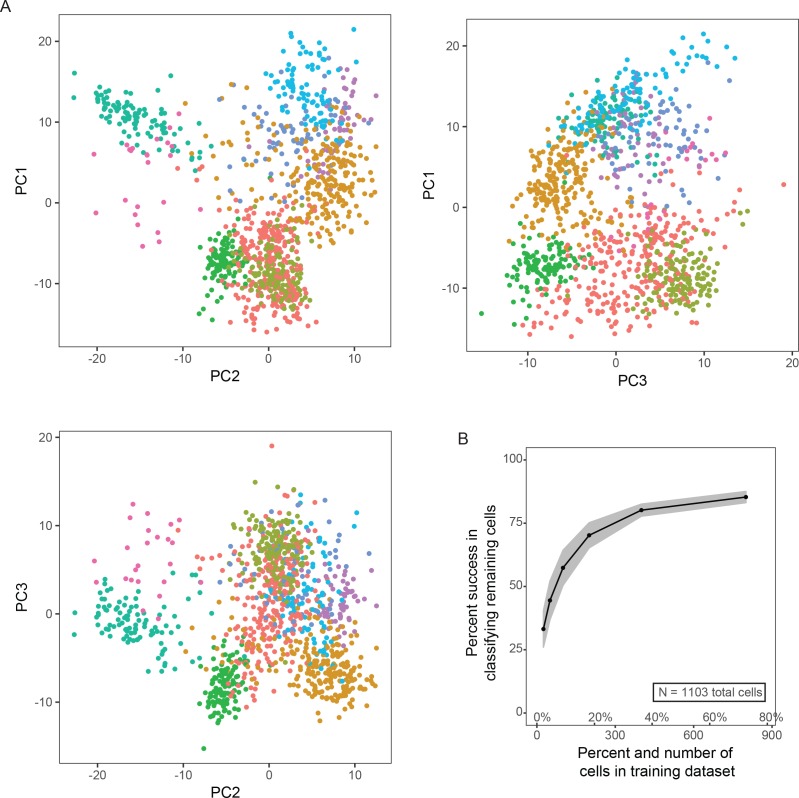
Expanded computational analysis of scRNA-seq data.(A) Projections onto the first three principal components are shown. (B) Random forest classification effectiveness. Here, for each iteration, a random subset of cells was chosen for classification (number of cells denoted by x-axis), and the remaining cells were used to test robustness of classification. One hundred simulations were run for each x value. Results are depicted as mean ± SD. Typically, misclassified cells reflected cells located on the extrema of clusters and/or cells occupying underrepresented clusters.